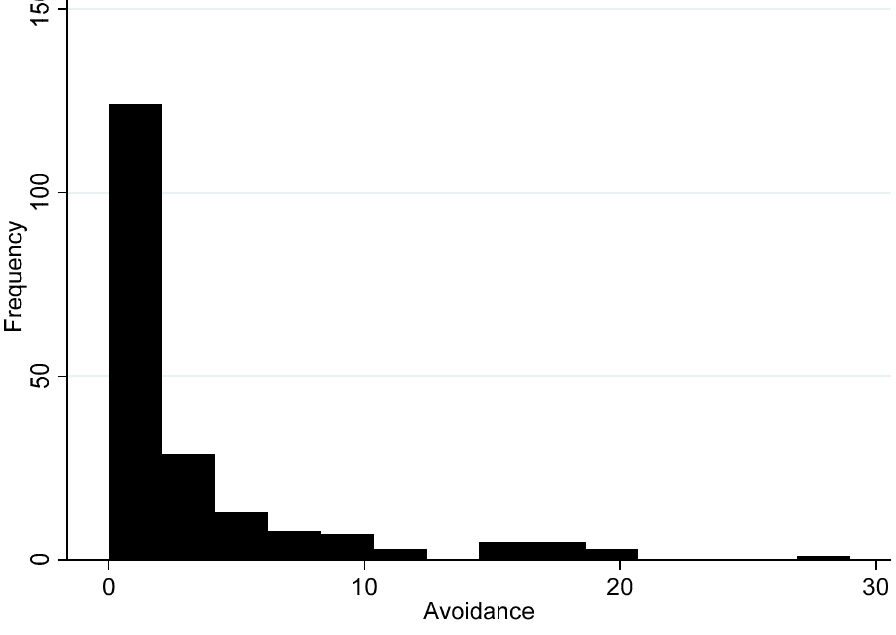
Figure 5. Histogram of avoidance subscale ( n = 198).